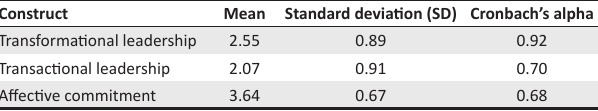
TABLE 2: Descriptive statistics and Cronbach alpha coefficients of measuring instruments.